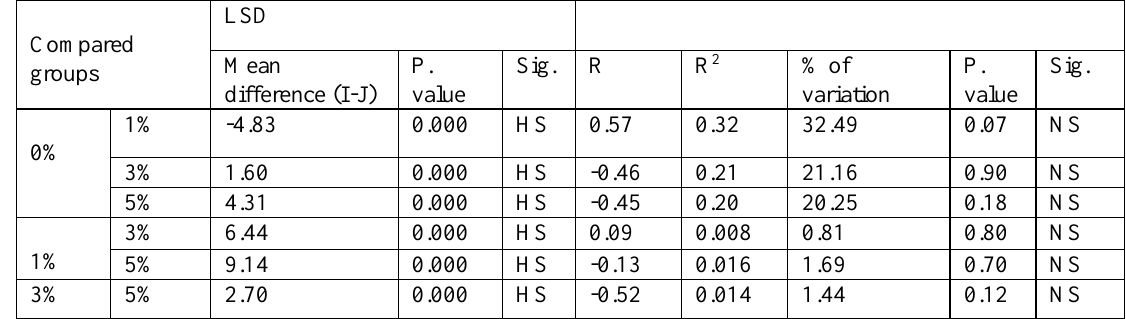
Table (2): Post-hoc LSD, Pearson correlation (R), Coefficient of determination (R 2 ) and % of variation for tear strength test Compared